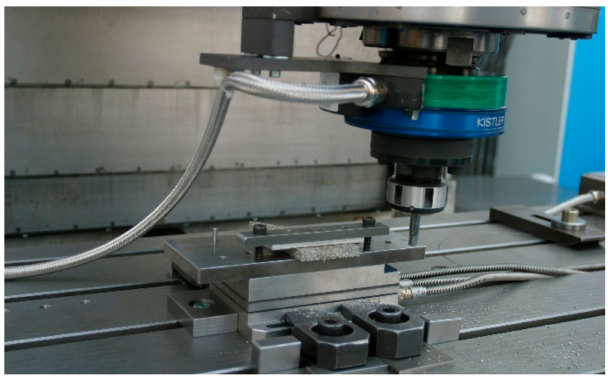
Figure 1. Experimental set-up for milling austenitic stainless steel cellular material (EN 1.4841, 45 ppi).